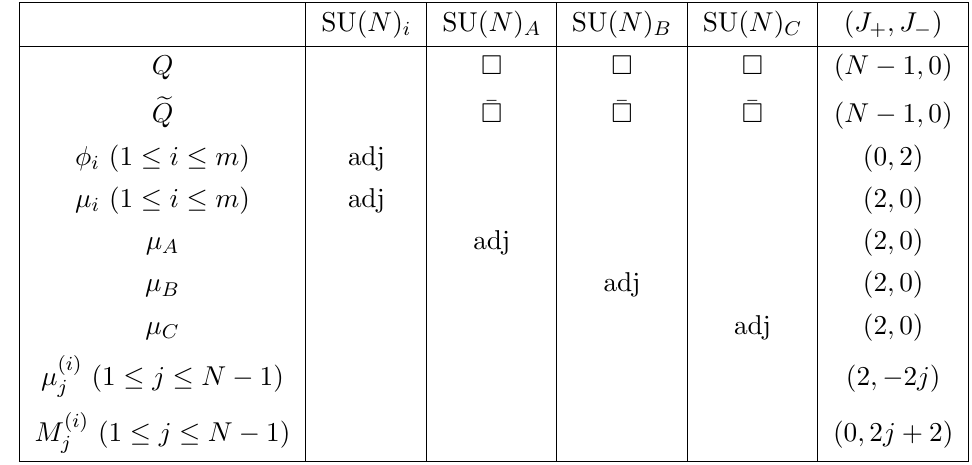
Table 1. Operators of the (unshaded) T ( m )